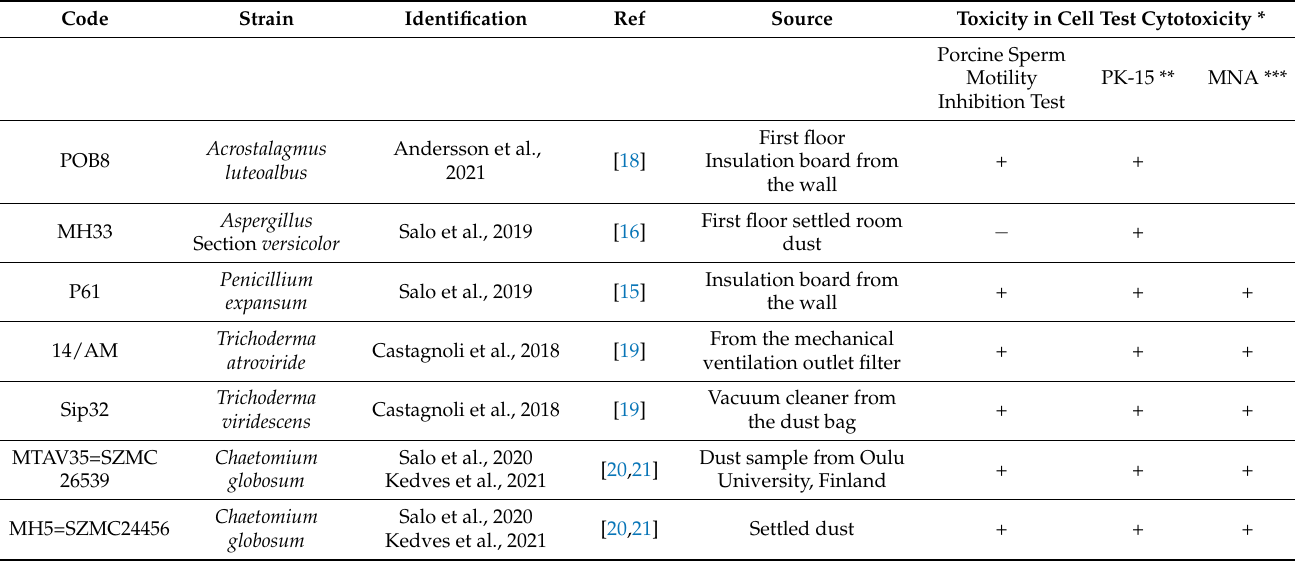
Table 1. Microbial strains isolated from the target building, expect for the Chaetomium globosum MTVA35 , which was from Oulu University. This target building was selected based on the previous publications and results of the toxicity